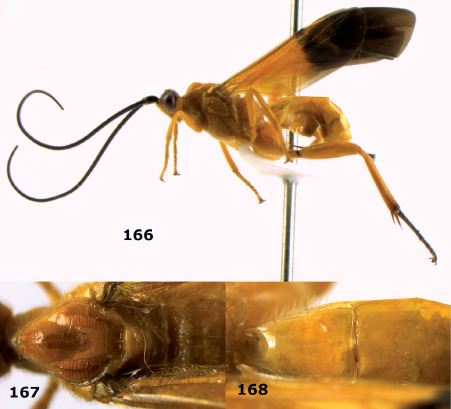
Euagathis chinensis (Holmgren), female, Dai Tu. 166 habitus lateral 167 mesosoma dorsal 168 first-third metasomal tergites dorsal.